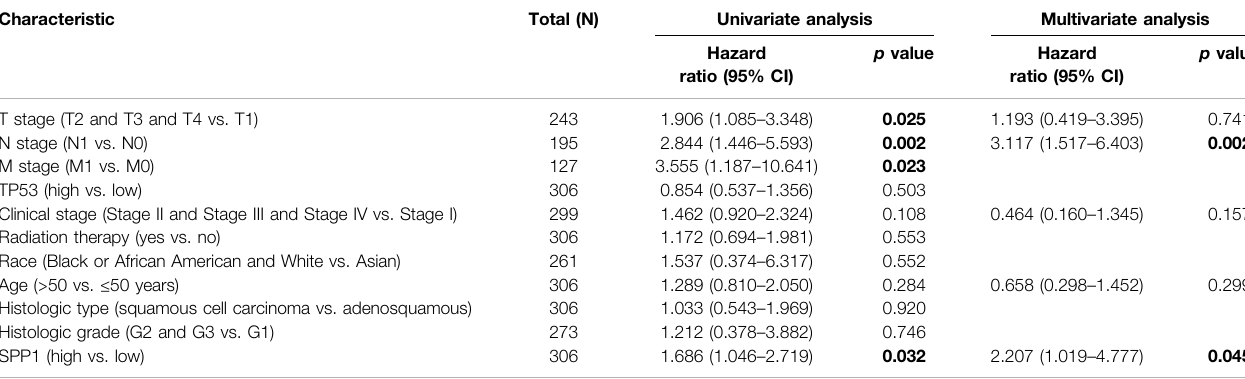
TABLE 3 | Univariate and multivariate Cox analyses of prognostic factors in cervical cancer. Characteristic